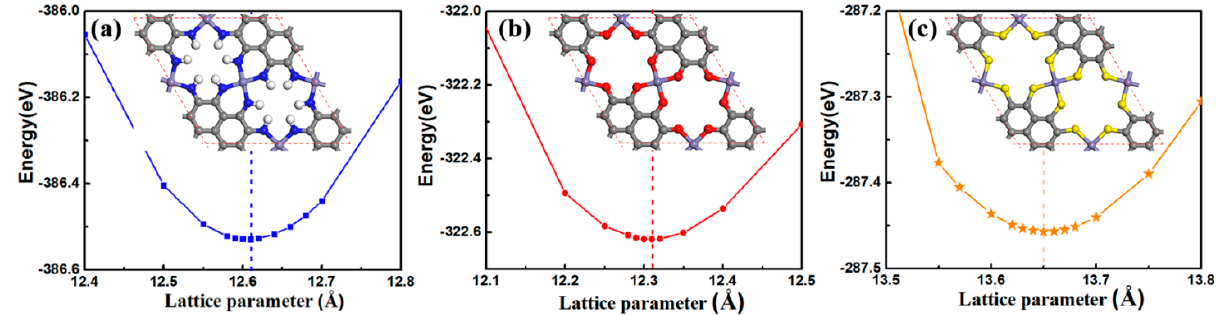
Figure 1. Optimized lattice parameters of ( a ) Fe-NH-MOF, ( b ) Fe-O-MOF, and ( c ) Fe-S-MOF monolayers.